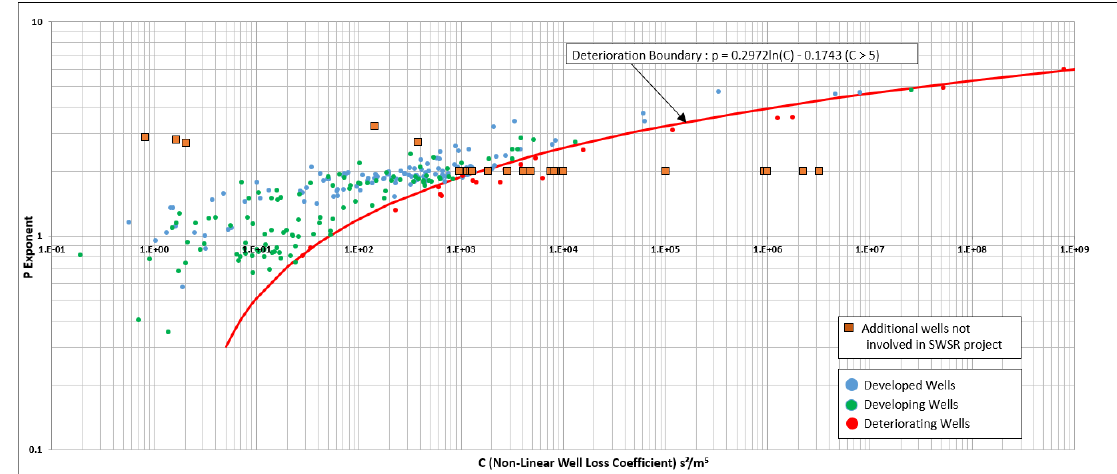
Figure 10. General Well Efficiency Criteria. Exponent Parameter (p) vs. Non-Linear Well-Loss Coefficient (C) Graph. The wells involved in the SWSR project are represented by circles. Wells represented by brown squares are collected from the literature and used to assess the GWEC. Table 3. Tabulated General Well Efficiency Criteria (GWEC).